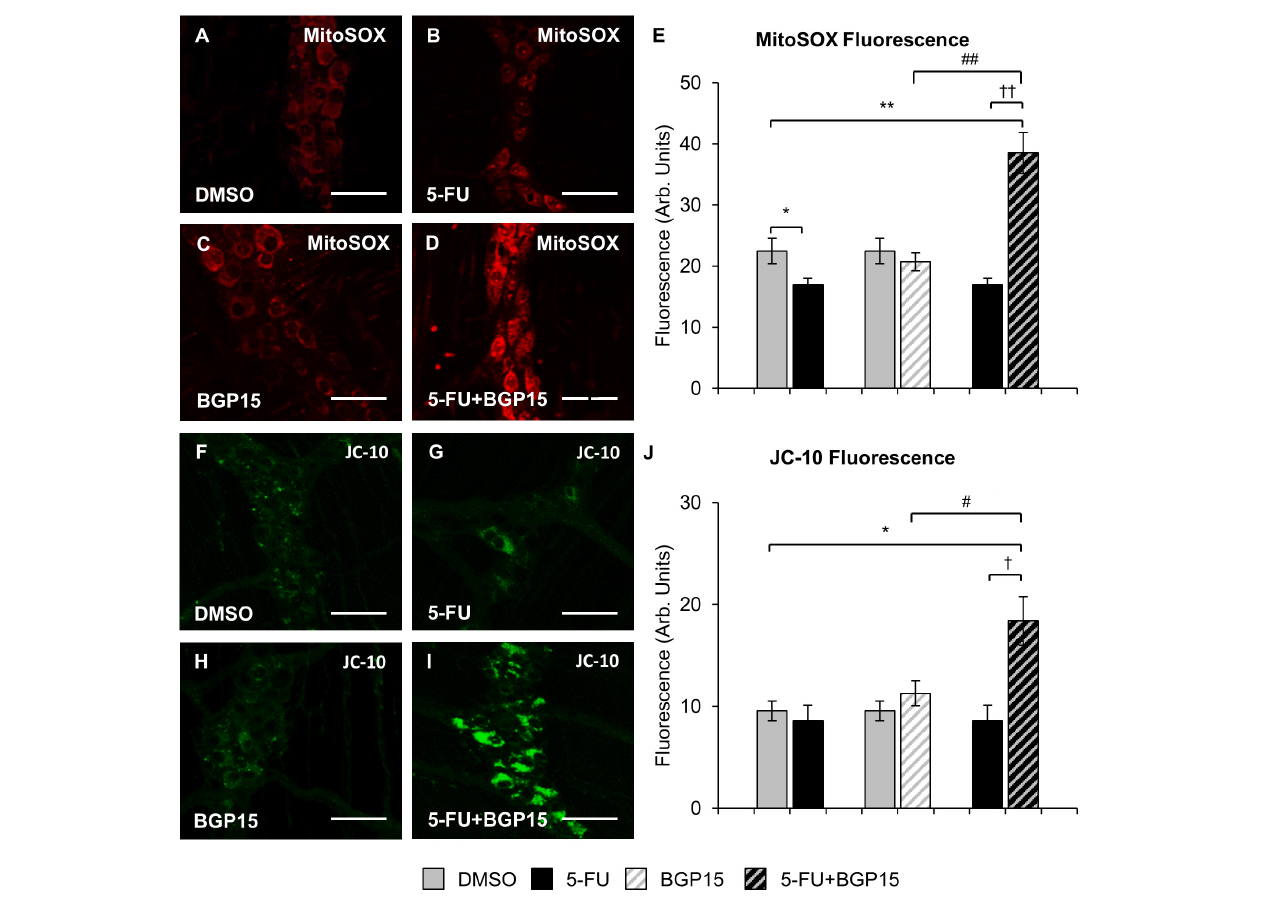
FIGURE 6 | Mitochondrial superoxide and mitochondrial membrane potential in the myenteric plexus following repeated in vivo 5-FU ± BGP-15 administration. Fluorescent wholemount preparations of the myenteric plexus labeled with MitoSOXTM Red M36008 in the colons from DMSO (A) , 5-FU (B) , BGP-15 (C) , and 5-FU+BGP-15-treated mice (D) , scale bar = 50 µ m. Quantification of the levels of MitoSOXTM Red M36008 production visualized by fluorescent probe in the myenteric plexus in colonic preparations from DMSO, BGP-15, 5-FU, and 5-FU+BGP-15-treated mice (E) . Fluorescent wholemount preparations of the myenteric plexus labeled with monomeric JC-10 in the colons from DMSO (F) , 5-FU (G) , BGP-15 (H) , and 5-FU+BGP-15-treated mice (I) , scale bar = 50 µ m. Quantification of the levels of monomeric JC-10 production visualized by fluorescent probe in the myenteric plexus in colonic preparations from DMSO, BGP-15, 5-FU, and 5-FU+BGP-15-treated mice (J) . Data represented as mean ± SEM. ∗ P < 0.05, ∗∗ P < 0.01 significantly different to DMSO group. † P < 0.05, †† P < 0.01 significantly different to 5-FU group. # P < 0.05, ## P < 0.01 significantly different to BGP-15 ( n = 5